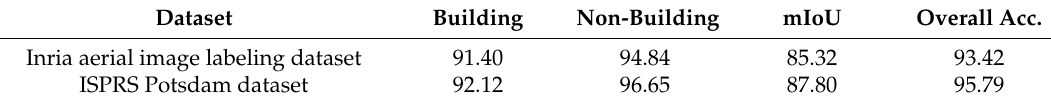
Table 4. Classification accuracy results of two standard datasets (%).